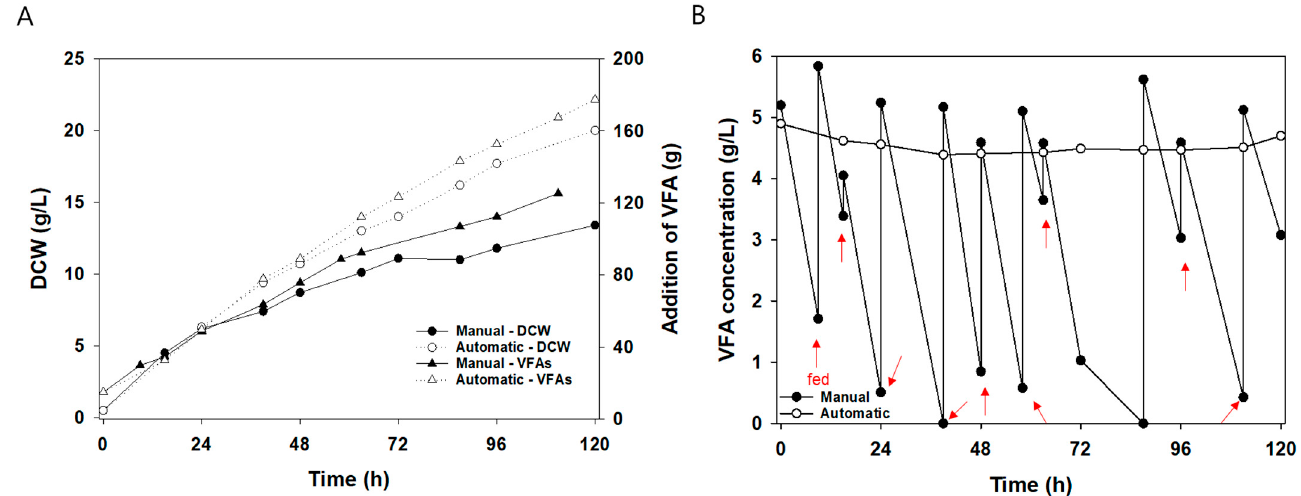
Figure 3. Two fed-batch cultivation modes with C. curvatus : ( A ) Dry cell weight and addition of VFA amount; ( B ) VFA concentration in broth. pH-stat for manual feeding used 5 N HCl as an acidic agent, and VFA solution was added ten times for fed-batch. The red arrows indicate when a VFA was added. Automatic feeding used 500 g/L VFA solution to obtain a pH of 7.0. The initial VFA concentration was 5 g/L.